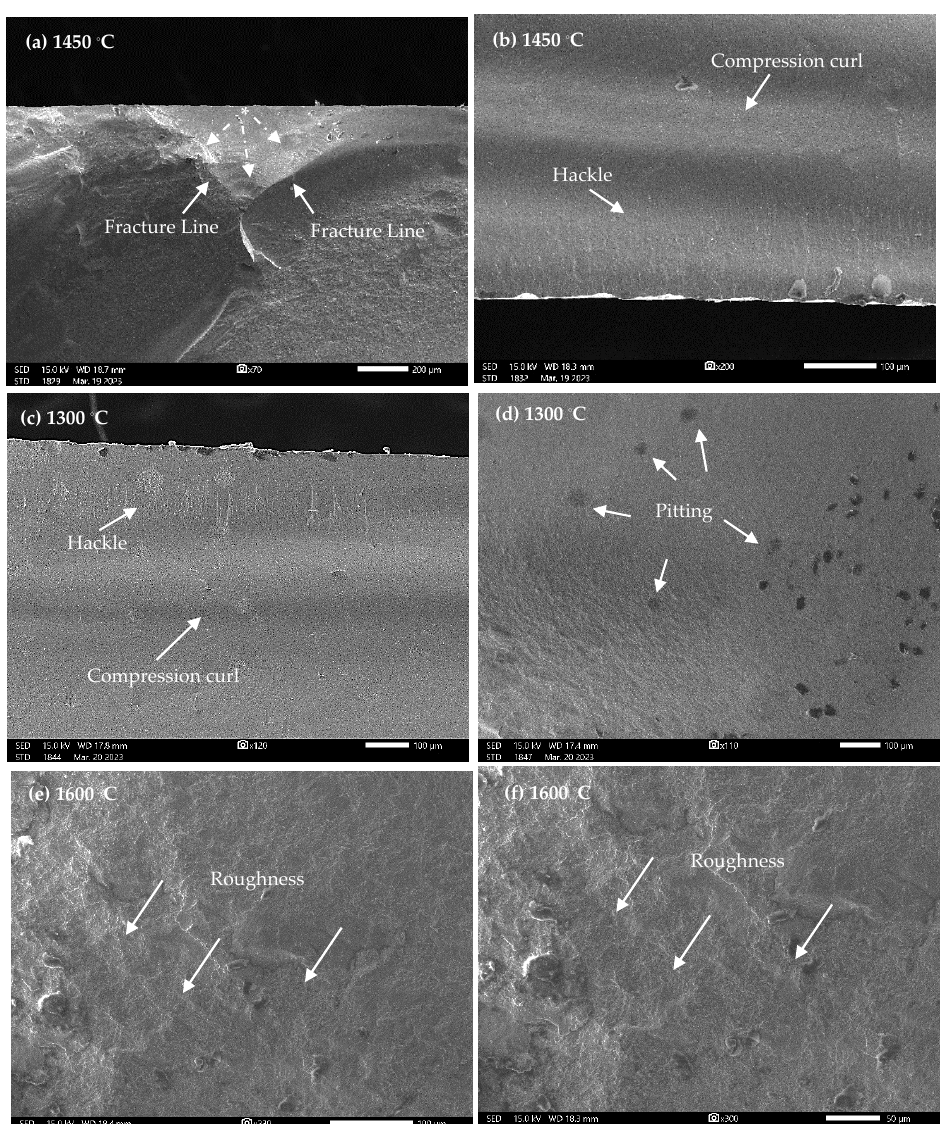
Figure 5. Representative SEM images of DD cubeX 2 ML (5Y-TZP) at different sintering temperatures. ( a ) A sample sintered at 1450 ◦ C showing the origin of fracture (asterisk) and direction of crack propagation (dotted arrows) along with fracture lines. ( b ) A higher magnification of the same sample shows a compression curl along with hackle lines on the opposite side of the fracture origin. ( c ) A sample sintered at 1300 ◦ C showing a smooth facture surface with a compression curl and hackle lines. ( d ) Increased amount of pitting is also seen in samples sintered at 1300 ◦ C. ( e ) A sample sintered at 1600 ◦ C showing increases in surface roughness. ( f ) Surface roughness and increased irregularities are seen in samples sintered at 1600 ◦